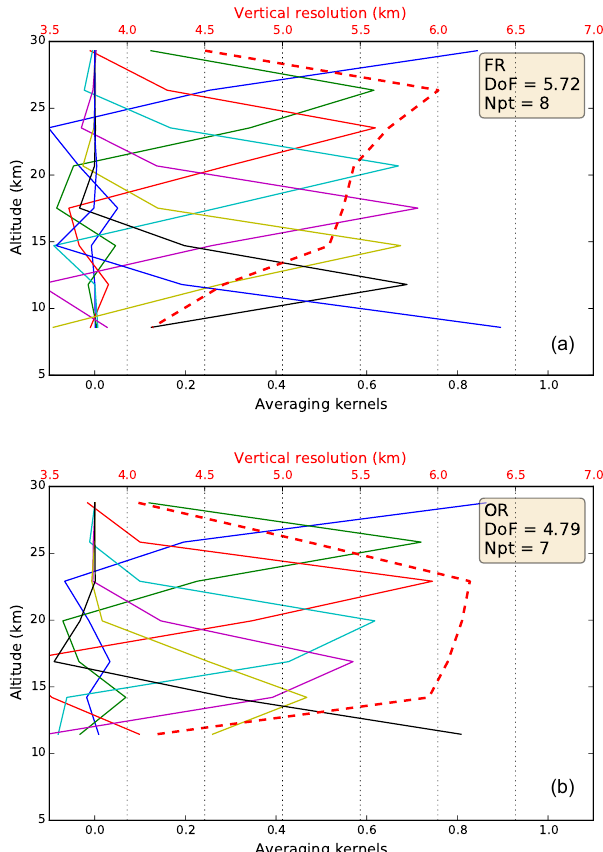
Figure 1. Typical averaging kernels (AKs, colored solid lines) and vertical resolution (red dotted lines) of CCl4 VMR retrieved from full resolution (FR, a ) and optimized resolution (OR, b ) MIPAS measurements. The vertical resolution is calculated as the FWHM of the AK rows. The plot’s key also shows the average number of degrees of freedom (DoFs) of the retrieval (trace of the AK matrix) and the number of retrieval grid points (Npt).